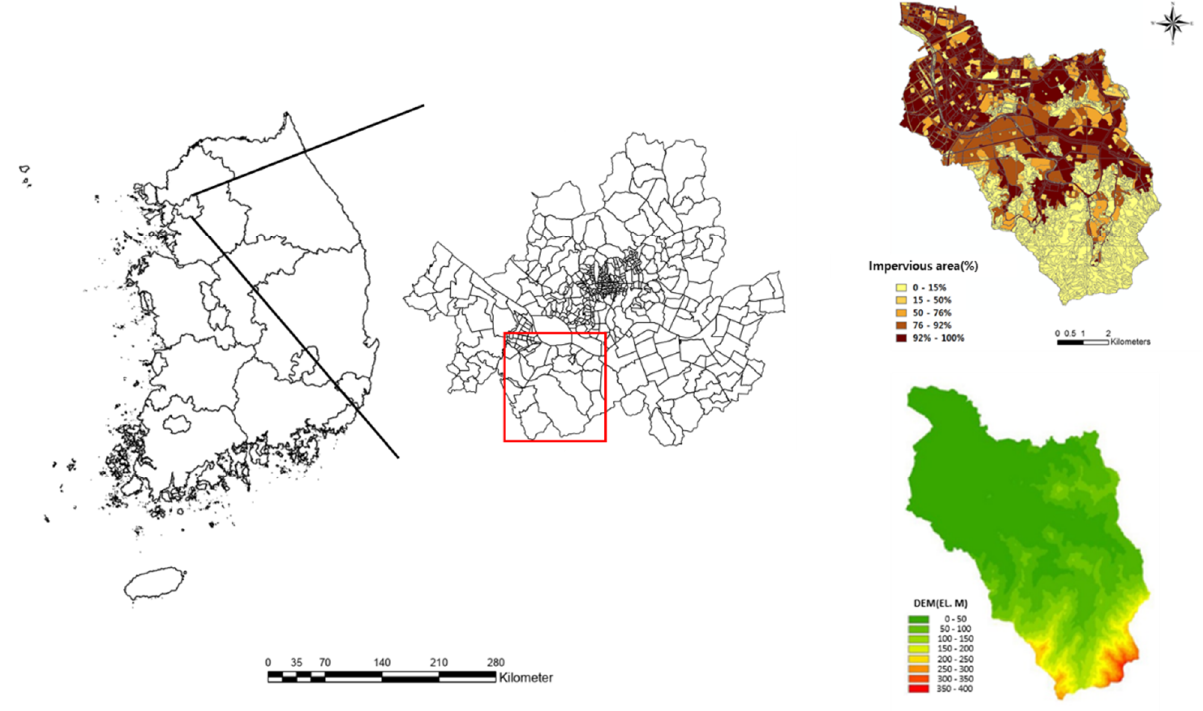
Figure 2. Study area for this cast study. Table 1. Dorim river isolation accident status.